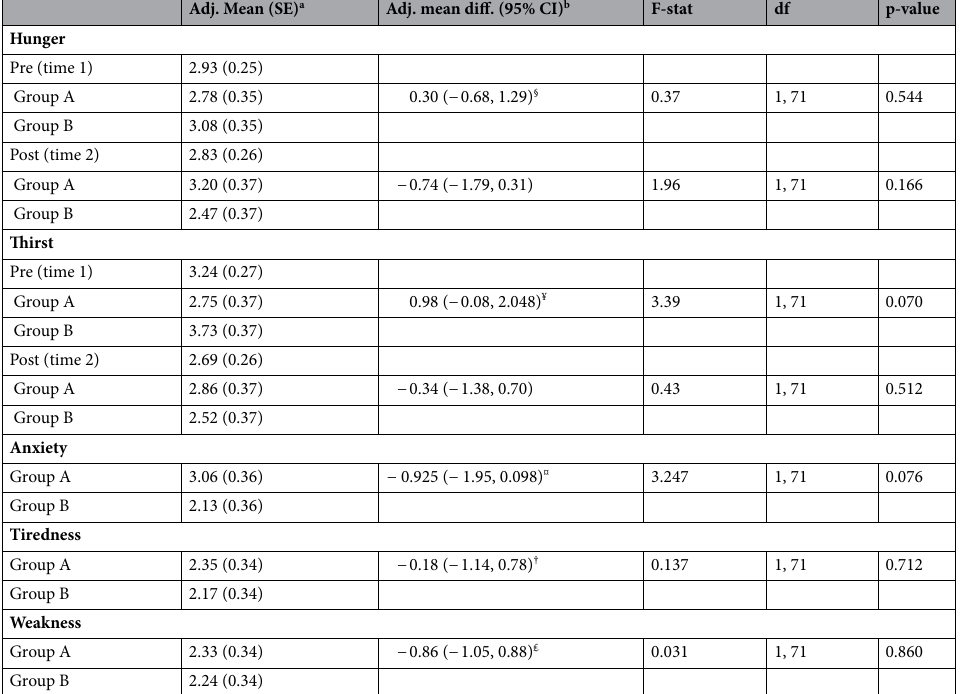
Table 3. Adjusted mean and mean differences between groups A and B using repeated measure ANCOVA. a Adjusted means using RM ANCOVA with pre-post, age, gender, BMI and duration between scope. b Bonferroni adjustment for 95% CI for difference. § No significant difference over time (pre &